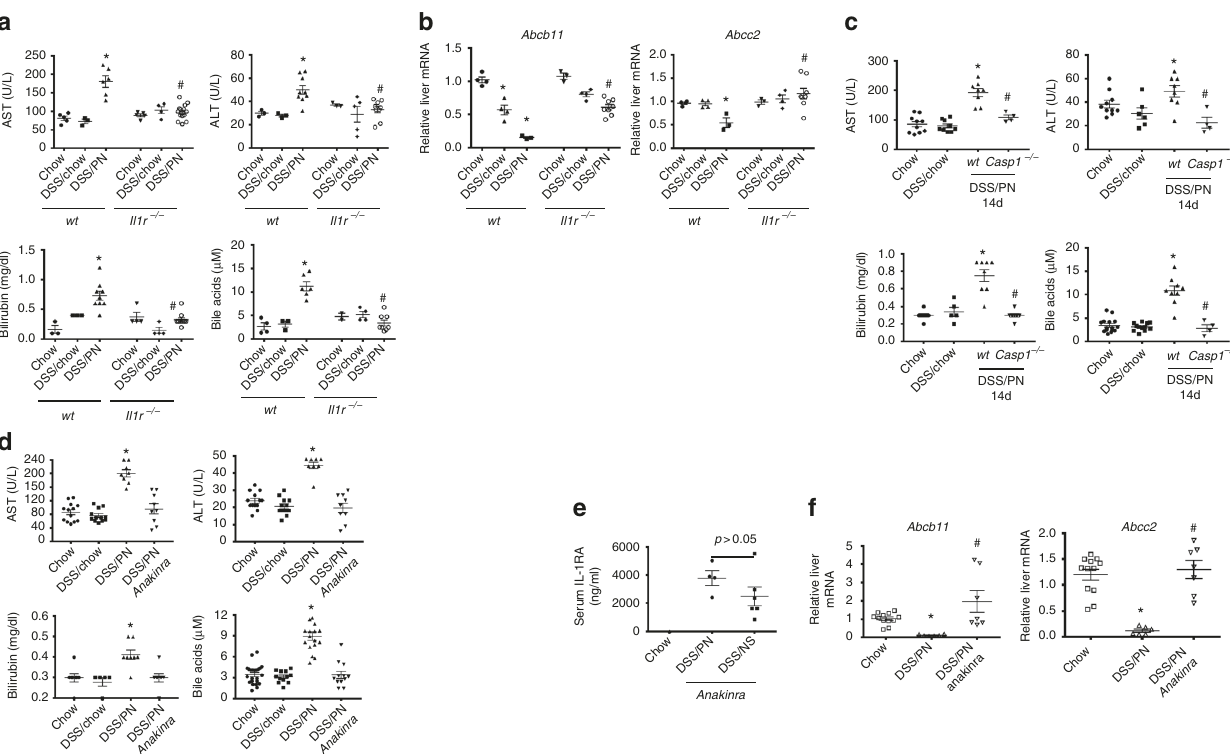
injection of 2.5 mg/kg LPS into WT mice resulted in increased Il1b transcription in both liver and isolated IHMCs (Fig. 2j) coinciding with suppression of hepatic Abcb11 and Abcc2 mRNA (Fig. 2k). Macrophage depletion was achieved in a separate group of mice by treatment with clodronate-liposome (Clo-lip), con fi rmed by liver F4/80 immunohistochemistry and reduction of mRNA for Emr1 , the gene encoding F4/80 (Supplementary Fig. 1E, F). In macrophage-depleted mice, LPS injection failed to both increase hepatic Il1b transcription (Supplementary Fig. 1G)